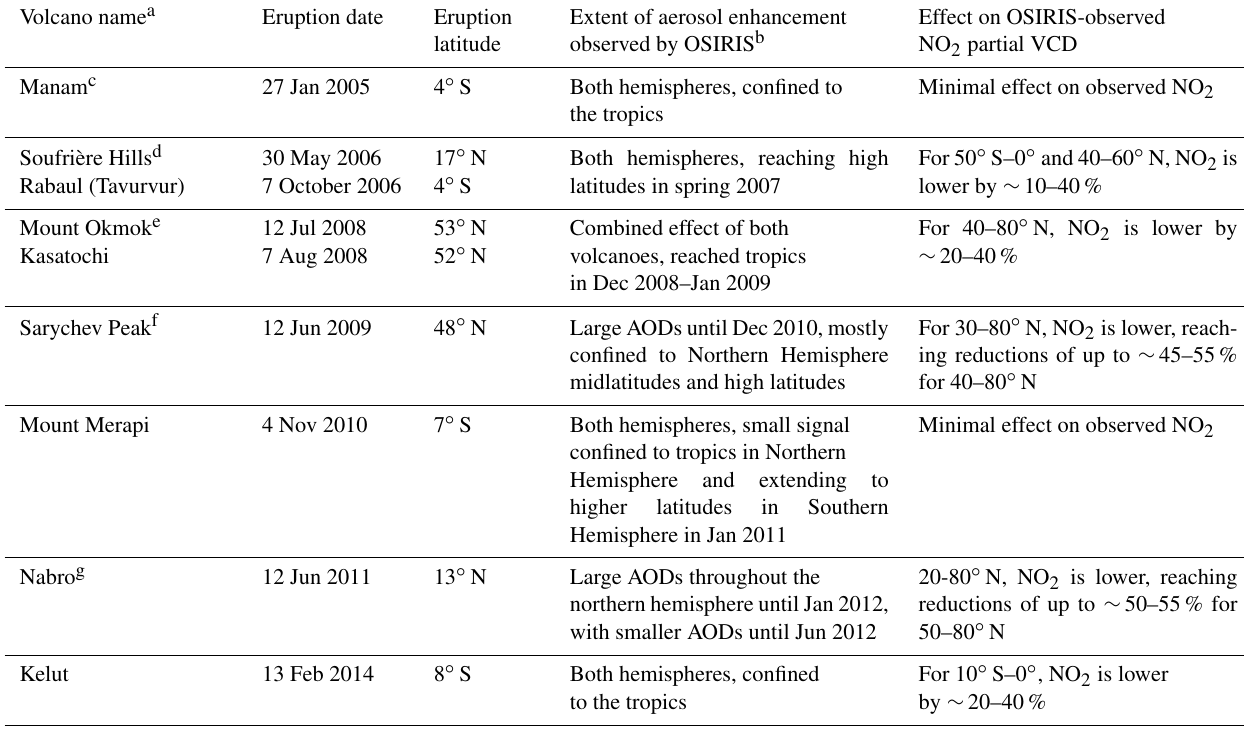
Table 3. Summary of volcanoes observed in OSIRIS partial-column AOD and associated with OSIRIS NO 2 VCDs. References given in the footnotes describe stratospheric aerosol following these eruptions. Note that this table lists eruptions that were followed by significant increases in OSIRIS aerosol extinction. Therefore, it does not include all volcanoes known to have affected the stratosphere during this time